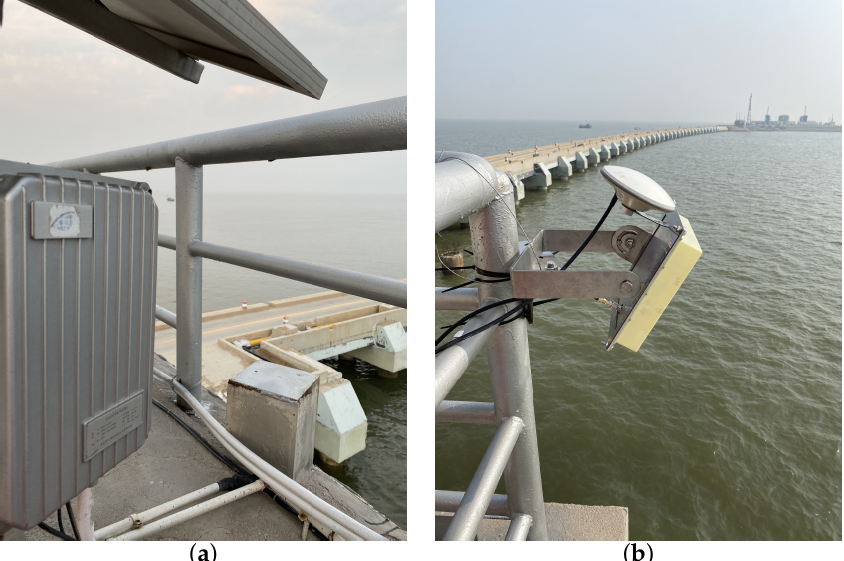
Figure 14. GNSS-R experiment setup at Dongying, China. ( a ) Sensor prototype mounted on the sea site; ( b ) Photograph of the side-looking antennas, including the RHCP antenna and LHCP